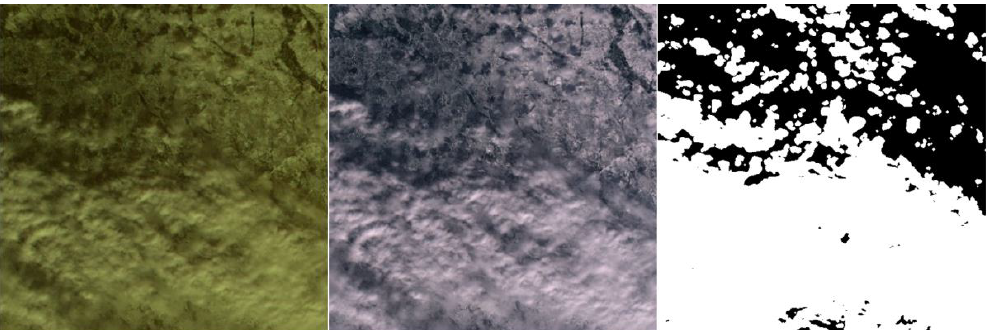
Figure 9. Bonneville clouds; radiance image, RGB image, cloud mask. False Negative case.